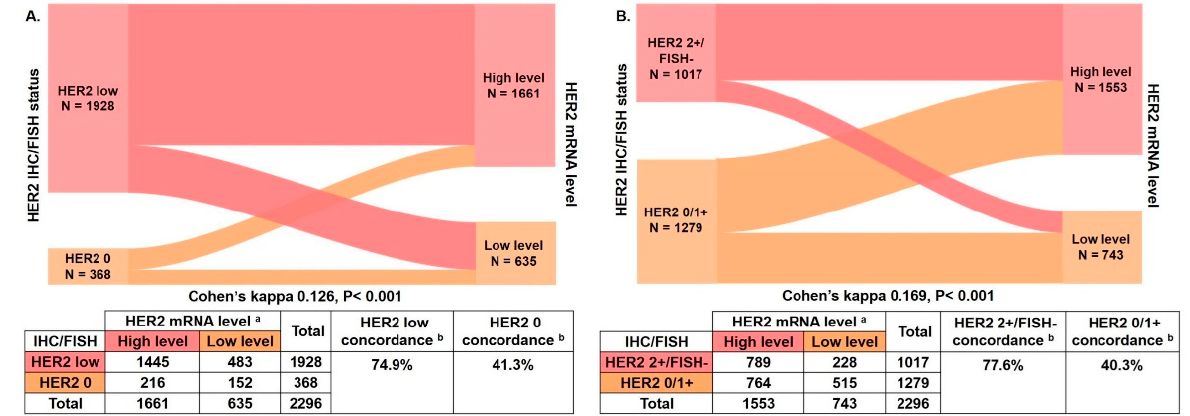
Figure 3. Concordance between HER2 IHC/FISH status and HER2 mRNA levels. ( A ) The percent concordances of HER2-low and HER2 0 were 74.9% and 41.3%, respectively, and Cohen’s kappa was 0.126, p < 0.001; ( B ) The percent concordances of HER2 2+/FISH − and HER2 0/1+ were 77.6% and 40.3%, respectively, and Cohen’s kappa was 0.169, p < 0.001. a HER2 mRNA expression level was classified as low level or high level by the ∆ CT cut-off value from the ROC curve; the ∆ CT cut-off between HER2 0 and HER2-low was 3.10 (low level, ∆ CT ≥ 3.10; high level, ∆ CT < 3.10); the ∆ CT cut-off between HER2 0/1+ and HER2 2+/FISH − was 2.98 (low level, ∆ CT ≥ 2.98; high level, ∆ CT < 2.98). b Concordance was calculated using IHC/FISH as standard test. Abbreviations: HER2, human epidermal growth factor receptor 2; IHC, immunohistochemistry; FISH, fluorescence in situ hybrid- ization; mRNA, message ribonucleic acid; CT, cycle threshold.